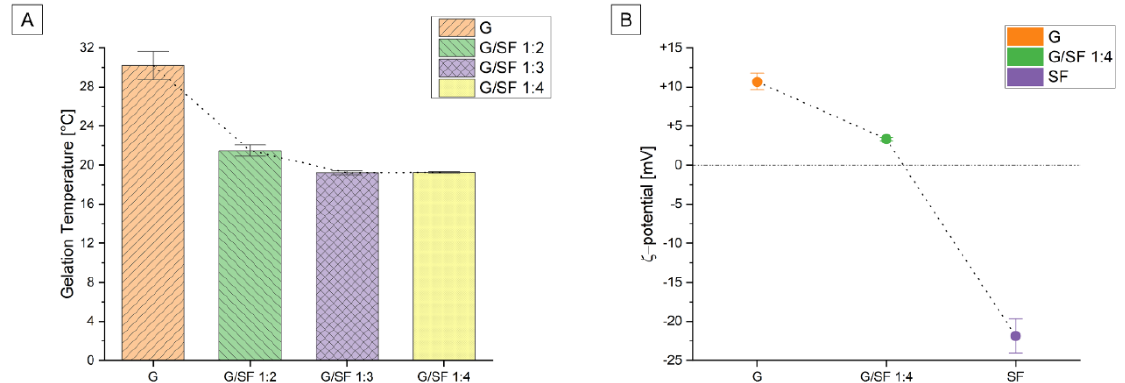
Figure 4. ( A ) The bar plots of the mean gelation temperatures with respect to the solution composition are reported along with the error bars. The dotted line indicates the trend connection line of the temperature mean values. The investigated solutions were pure gelatin (G) and the mixture of gelatin/silk fibroin in different volume ratios, respectively, of 1:2, 1:3, and 1:4. ( B ) The ξ -potential interval plot showing the mean value and the SD error bar of pure gelatin (G), G/SF 1:4, and pure silk fibroin (SF) is reported with the mean trend